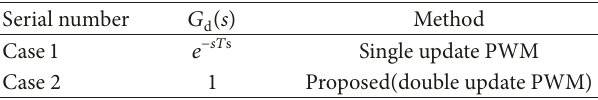
Table 1: The delay comparison between the single update PWM and proposed